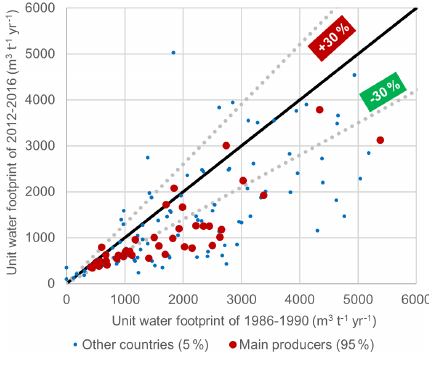
Figure 8. Comparison of the national unit water footprints of maize (m 3 t − 1 yr − 1 ) between the average of 1986–1990 and the av- erage of 2012–2016. The black line represents no change, and the dotted grey lines show + 30% and − 30% changes.